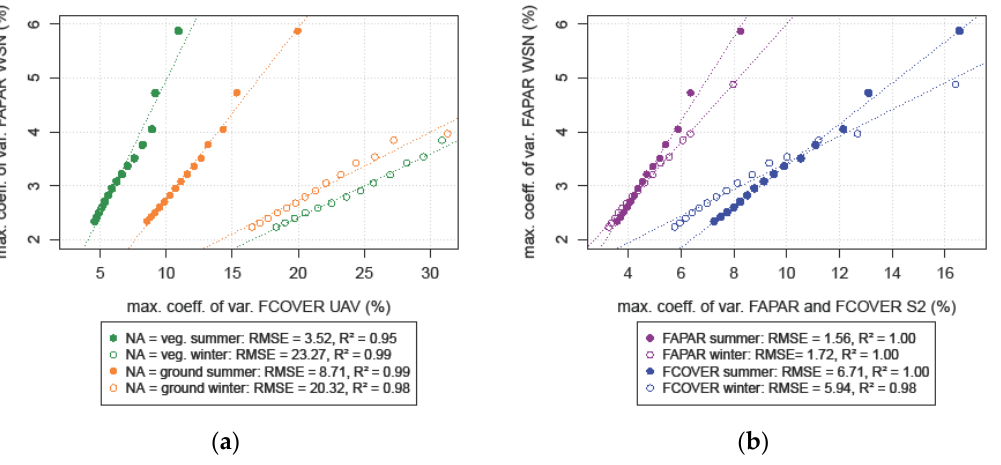
Figure 13. Scatterplots of the maximum coefficient of variation between FAPAR-WSN and ( a ) FCOVER-UAV, as well as ( b ) S2 products, for the spring and summer acquisition dates.